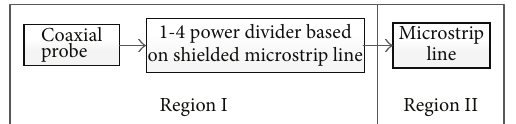
Figure 2: Block diagram of the feeding network configurations.